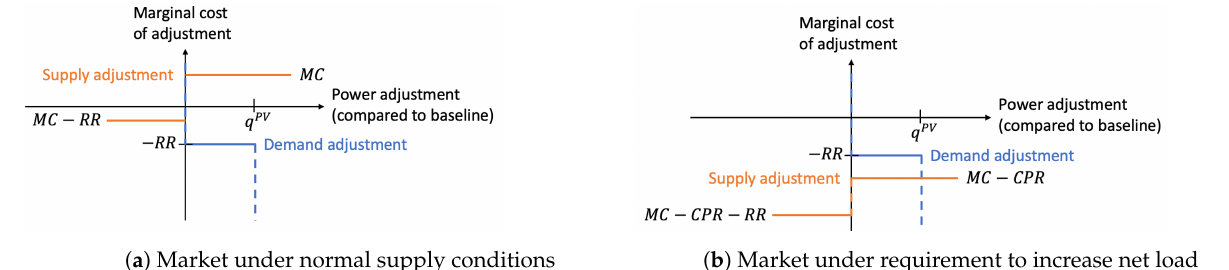
Figure 4. Market for power adjustment (compared to